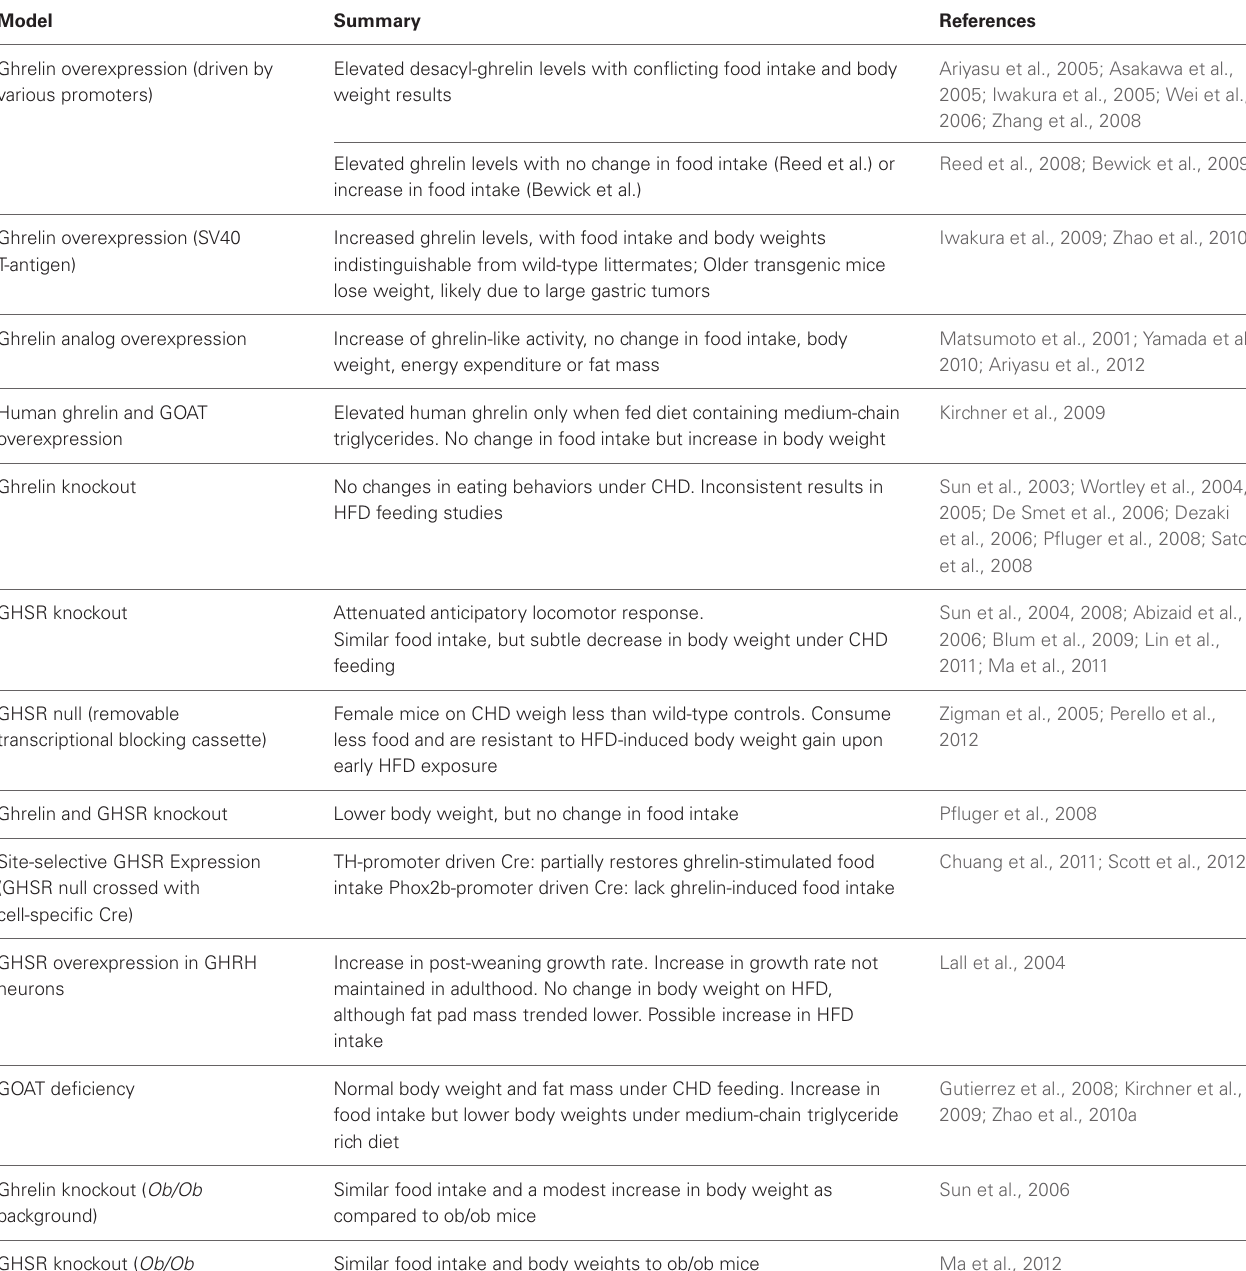
Table 1 | Studies of homeostatic eating behaviors in mouse models with genetic alterations in ghrelin-signaling system.